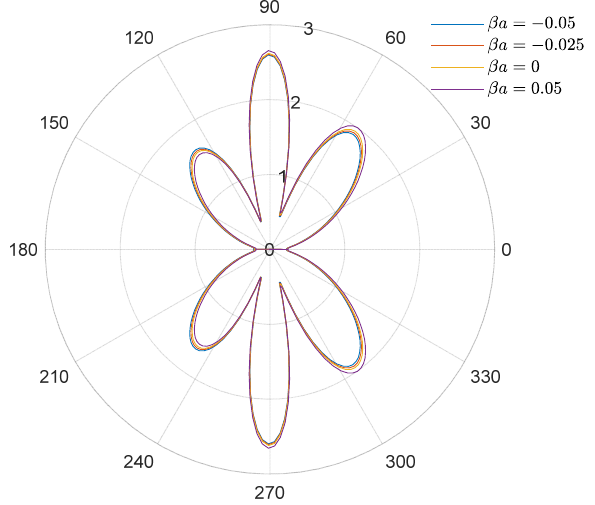
Figure 5. Polar graph of DSCC around the elliptical opening with ka = 1.0 and m = 1/4.